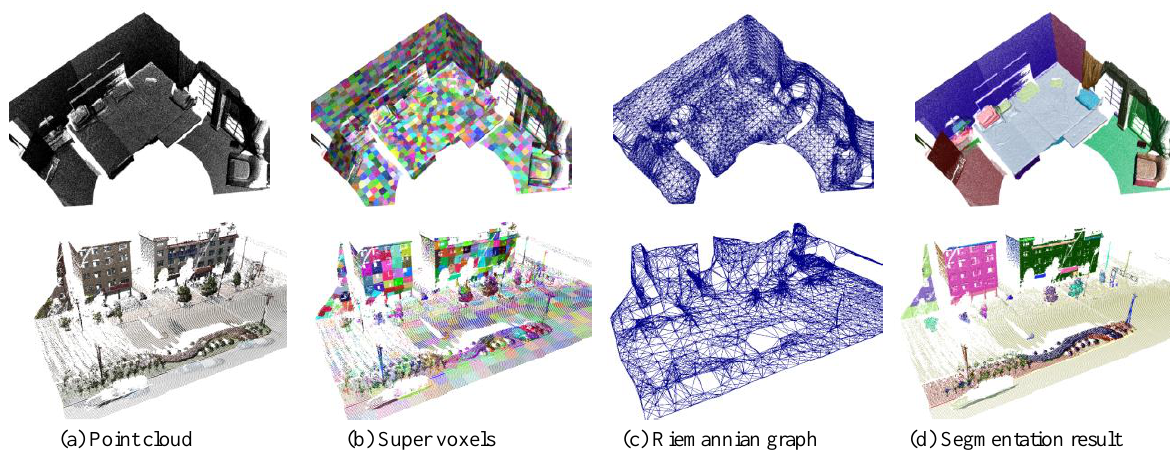
Figure 6. Example visualizations on both datasets. The colours in (b) and (d) are chosen randomly for each